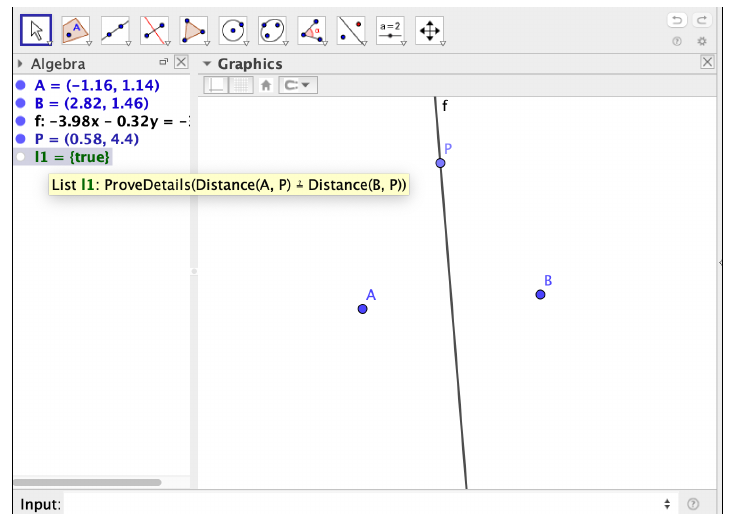
Figure 1. Proving with GeoGebra that the distances from a point P in the perpendicular bisector of segment AB to its extremes are